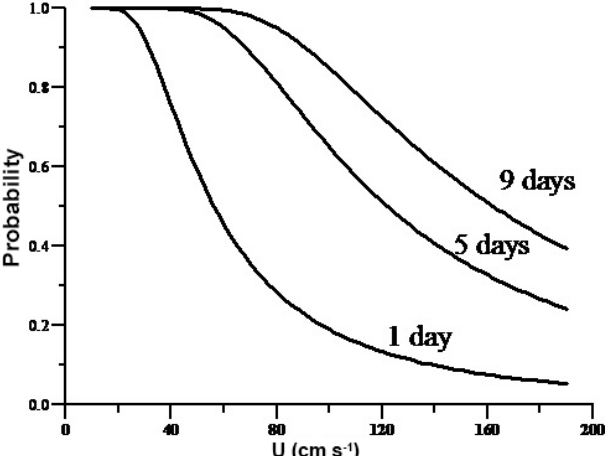
Figure 2. Probability of occurrence of internal waves at the north- western shelf of